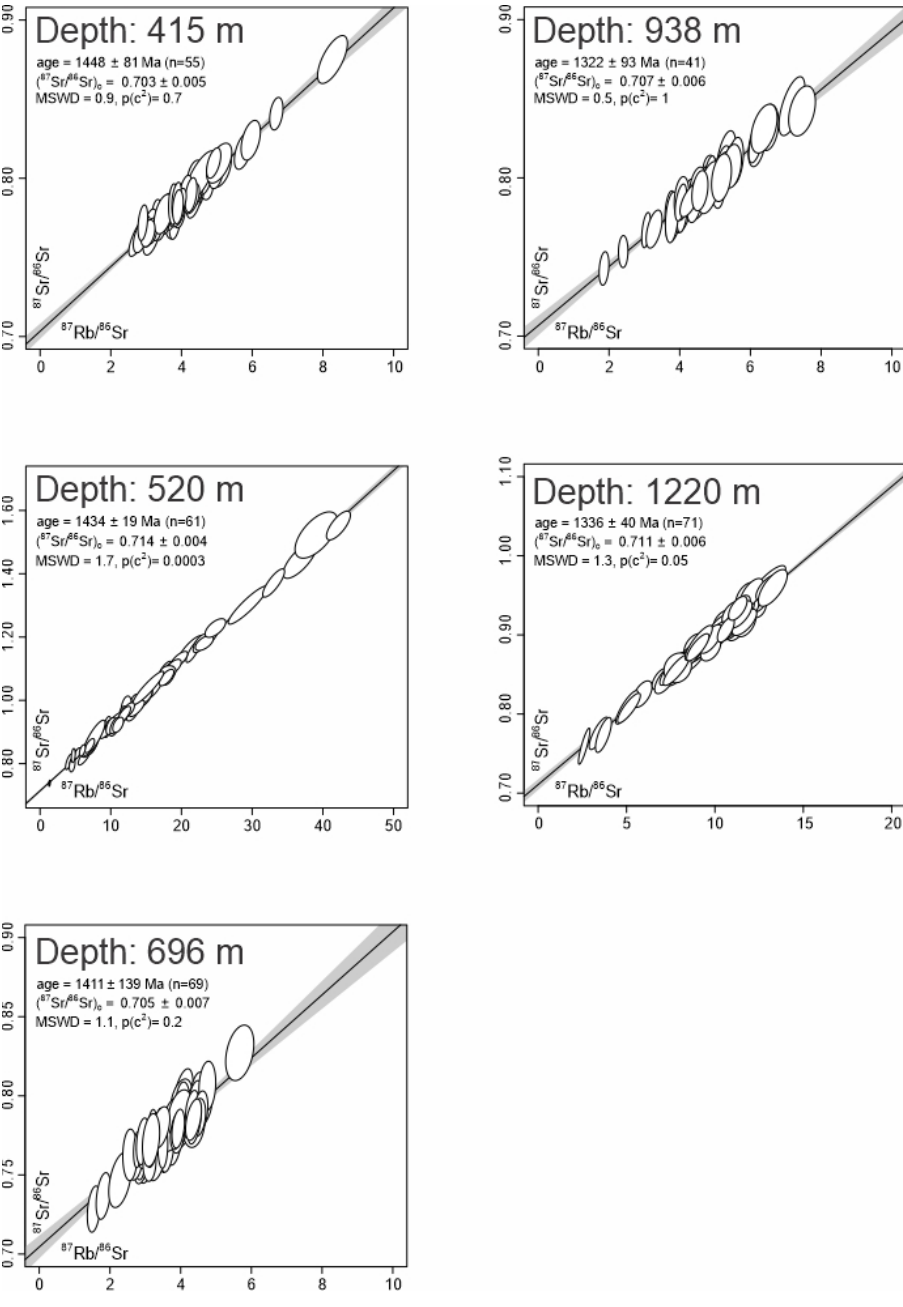
ple, however, are lower than the inferred closure tempera- tures for observed K–Ar and Rb–Sr in sheet silicates (Dod- son, 1973; Tillberg et al., 2020; Torgersen et al., 2015; Yoder and Eugster, 1955). In a scenario in which a sill of thick- ness 75 m was intruded below samples, rocks from present- day depth of 938 m are only predicted to have experienced maximum heating to ca. 110 ◦ C (Fig. 9c), with temperatures exceeding 100 ◦ C for a duration of only ca. 150 ka (Fig. 9b).